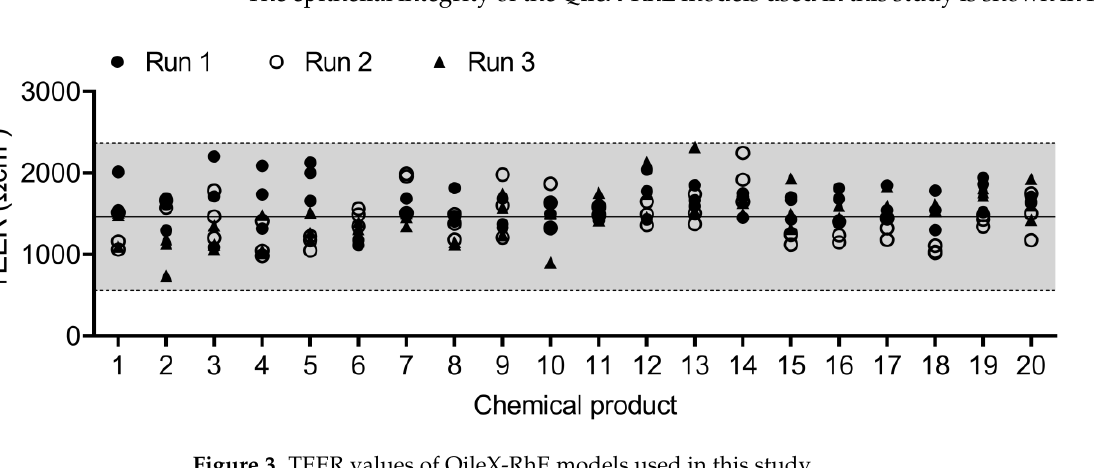
Table 2. Lipid composition of QileX-RhE, validated reference method and native epidermis. Lipids